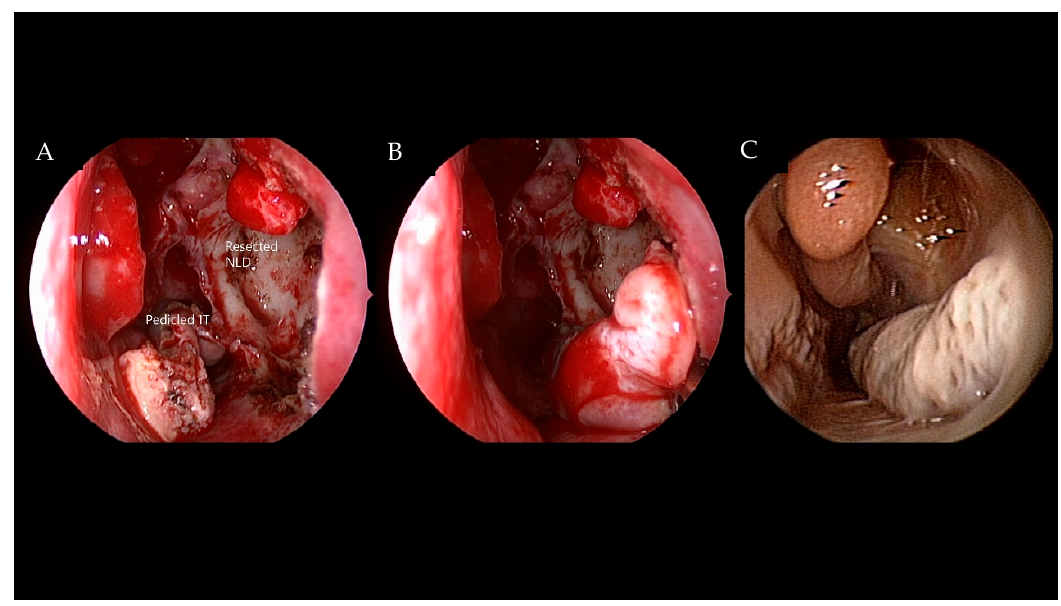
Figure 1. Modified endoscopic medial maxillectomy approach with preservation of the inferior turbinate. ( A ) Lacrimal duct has been resected. The inferior turbinate is pedicled posteriorly providing a wide access to the left maxillary sinus. ( B ) After complete removal of the inverted papilloma, the inferior turbinate is repositioned. ( C ) Postoperative 1-year endoscopic view of the left nasal cavity with well-preserved inferior turbinate. IT—inferior turbinate; NLD—nasolacrimal duct.